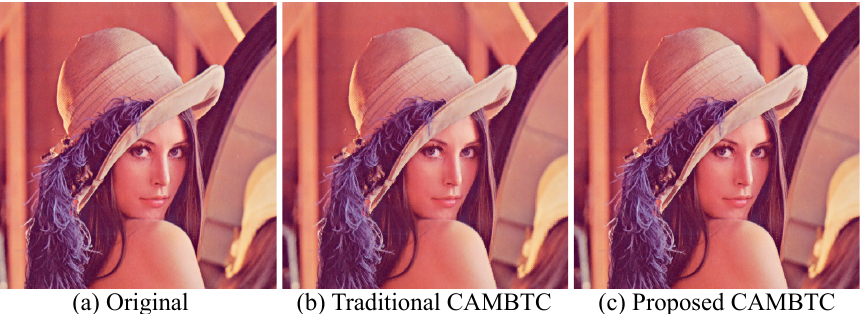
Figure 7. Comparison of original Lena, traditional CAMBTC, and the proposed CAMBTC’s